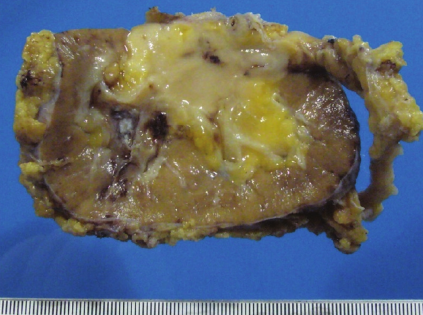
Figure 3: Macroscopic study after surgery that revealed a TCC of the renal pelvis with fat invasion and extension to proximal portion of the ureter, where it infiltrates the muscular layer. Surgical margin was free of tumor, and the stage was a pT3G4.